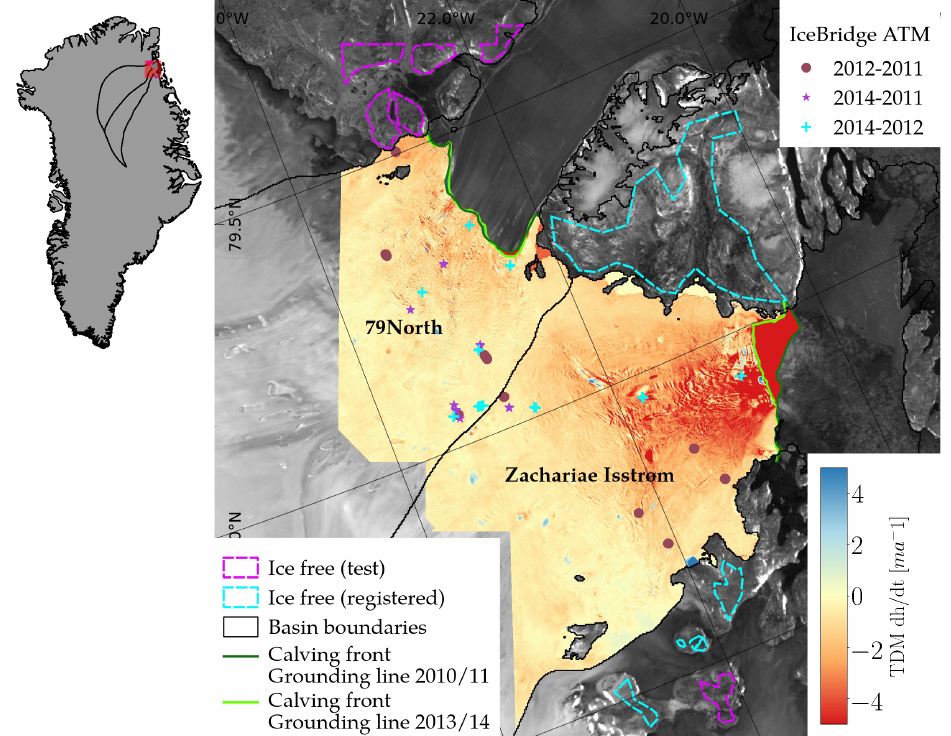
Figure 1. Surface elevation change rates for Zachariæ Isstrøm and 79North measured by DEM differencing of TDM mosaics from winter 2010 and winter 2013. Ice free areas that have been used for vertical co-registration (blue) and uncertainty estimation (magenta) are superimposed on the TDM global DEM backscattering mosaic. Available locations of IceBridge ATM dh indicated for various sub-epochs. A detailed comparison to the IceBridge ATM data can be found in Section